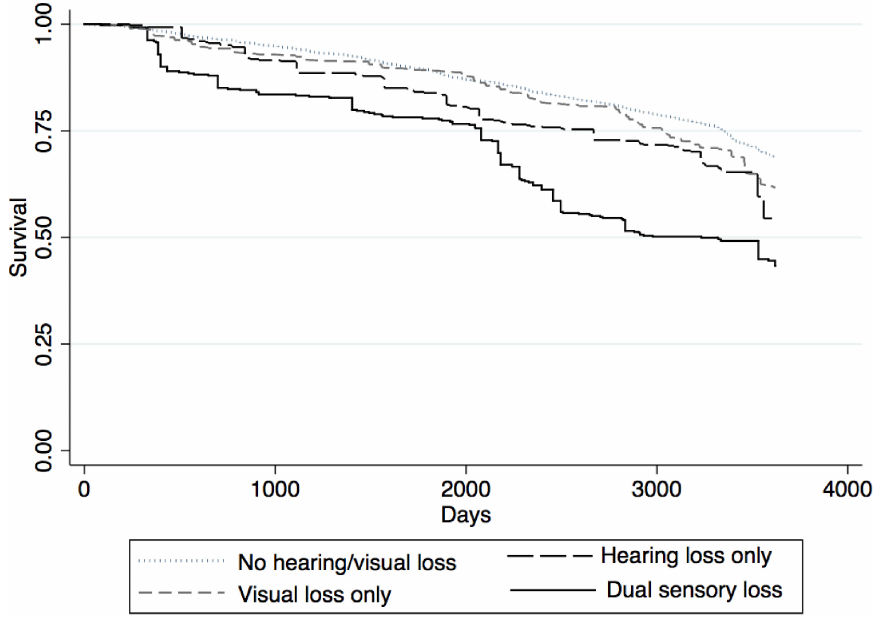
Figure 1. Age- and sex-adjusted survival curves for each status of the sensory loss.